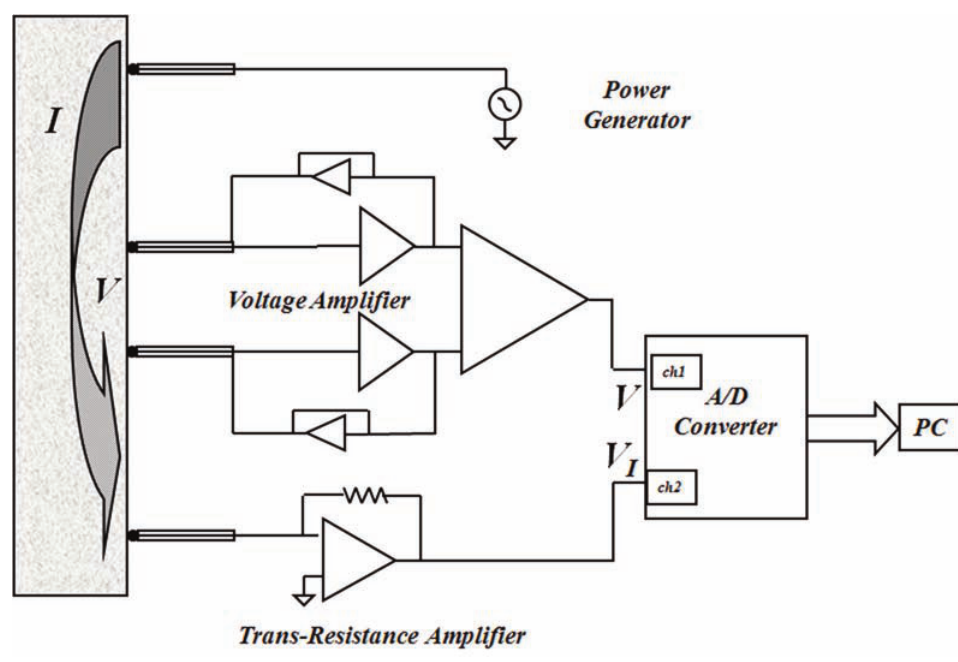
Figure 1. Block diagram of the measuring system that is composed of: a series of four electrodes laid on the material to be investigated; an analog circuit for the detection of signals, connected to a high voltage sinusoidal generator; a digital acquisition system; and a personal computer. The four electrodes are laid on the block of material to be analyzed. Two electrodes are used to generate and measure the injected current (at a selected frequency), while the other two electrodes are used to measure the potential difference. In this way, two voltages are obtained: the first proportional to the current; the second proportional to the difference of potential. These voltages are digitized through a analog–digital converter (A/D converter) connected to a personal computer (PC) for further processing. The real magnitudes hereby measured in the time domain are subsequently transformed into complex magnitudes in the frequency domain. From the ratio of the complex values, at the specific investigated frequency, it is possible to obtain the complex impedance. A program with an algorithm of numerical inversion allows the electrical resistivity and dielectric permittivity of the material to be obtained by measuring the transfer impedance; in this way, the reliability of the measured data is immediately analyzed, which is very useful during a measurement